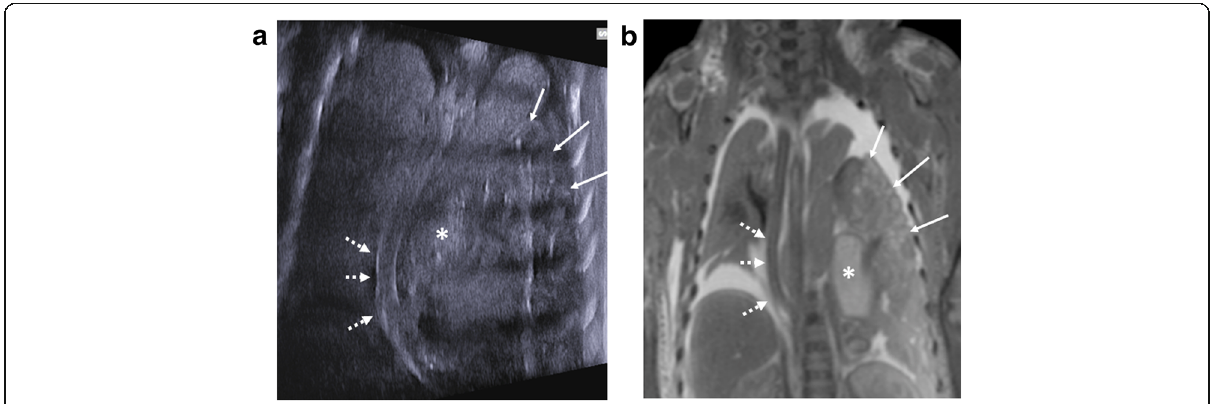
Fig. 12 Large left sided congenital diaphragmatic hernia in a foetus at 24 weeks gestation, following termination of pregnancy. Post-mortem ultrasound and MRI were performed 24 hours apart, 12 days after death. Coronal plane imaging of the thorax at post-mortem ultrasound ( a ) and post-mortem T2 weighted MRI at 1.5T ( b ) show herniated bowel loops (solid white arrows), herniated stomach (asterisk) and the deviated course of the oesophagus (dotted white